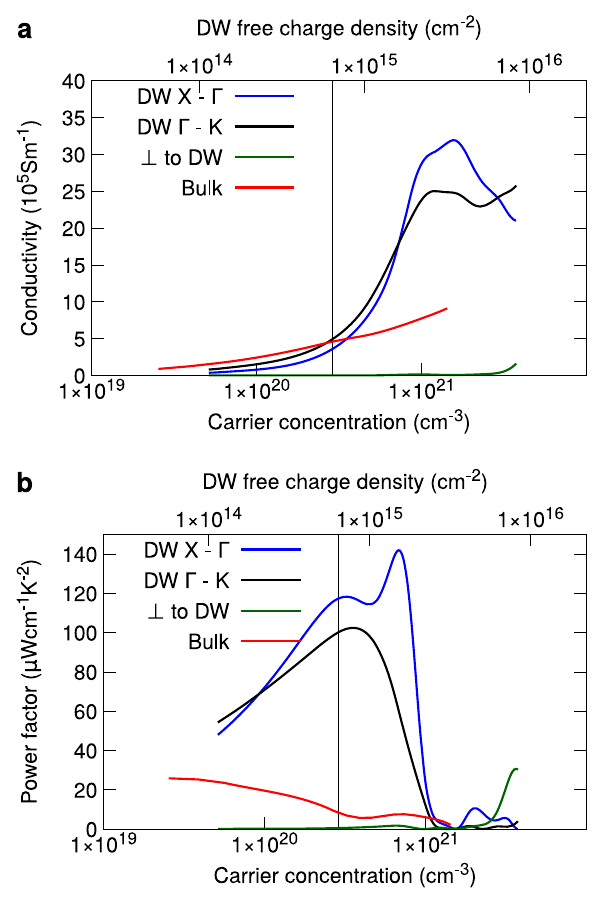
Fig. 6 Thermoelectric transport properties of the tail-to-tail domain wall. Calculated a electrical conductivity and b power factor of p-type bulk GeTe and 39° (11 1 ) tail-to-tail (T-T) domain walls (DWs) for various directions at 300 K. The top x -axis shows the DW interface free charge density, while the bottom x -axis corresponds to the volume charge concentration for the DW separation of 5.6 nm. Black vertical line shows the intrinsic doping concentration of the T-T DW for this DW separation due to charge transfer between the head-to-head and T-T DWs.